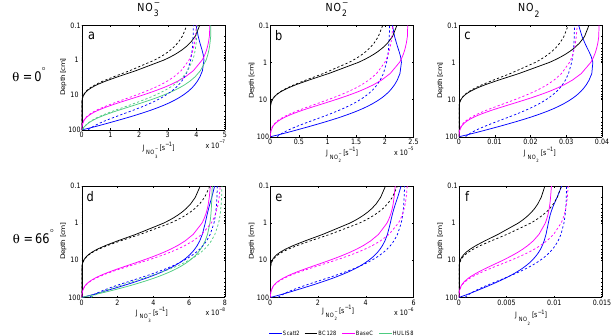
Figure 6. Photolysis rate coefficient for the NO − anion ( a 3 and d ), the NO − anion ( b and e ) and NO 2 ( c and f ) com- 2 puted by TUV (solid line) and z e method (dashed line) at two different solar zenith angles, θ , at 0 ◦ (top row) and 66 ◦ (bottom row). Maximum and minimum depth-integrated pho- tolysis rate coefficient ratio occurred at θ = 0 ◦ and θ =∼ 66 ◦ respectively. Blue is the “melting snow”, Scatt2 ( ρ = 0.4gcm − 3 , [BC] = 4ng ( C ) g − 1 and σ scatt = 2m 2 kg − 1 ); black is the “heav- ily black carbon polluted snow”, BC128 ( ρ = 0.4gcm − 3 , [BC] = 128ng ( C ) g − 1 and σ scatt = 25m 2 kg − 1 ); magenta is the “BaseC snow” BaseC ( ρ = 0.4gcm − 3 , [BC] = 4ng ( C ) g − 1 and σ scatt = 25m 2 kg − 1 ); and green is the “HULIS-polluted snow”, HULIS8 ( ρ = 0.4gcm − 3 , [HULIS] = 8ngg − 1 and σ scatt = 25m 2 kg − 1 ). Surface (depth = 0cm) values of photolysis rate coefficient from the “RT method” and “ z e method” are the same (see Eq. 8 for calculation of J TUV